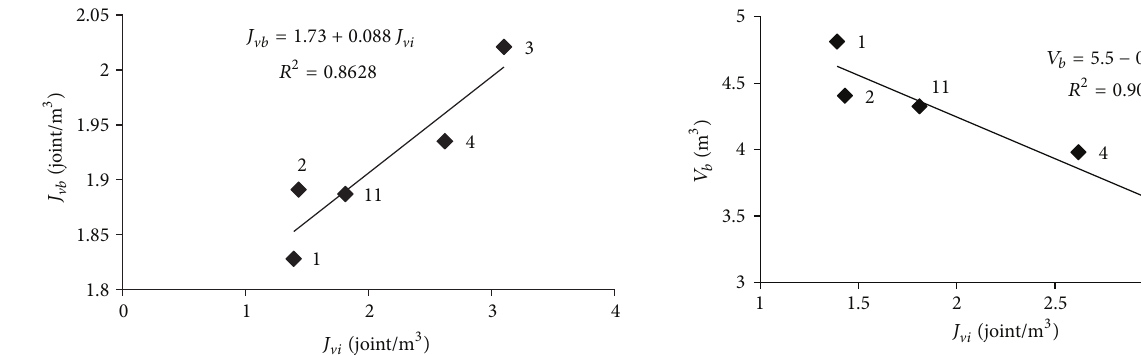
Figure 6: Mean in situ volumetric joint count (𝐽 V 𝑖 ) versus mean block volumetric joint count (𝐽 V 𝑏 ) for the Karaburun limestone.